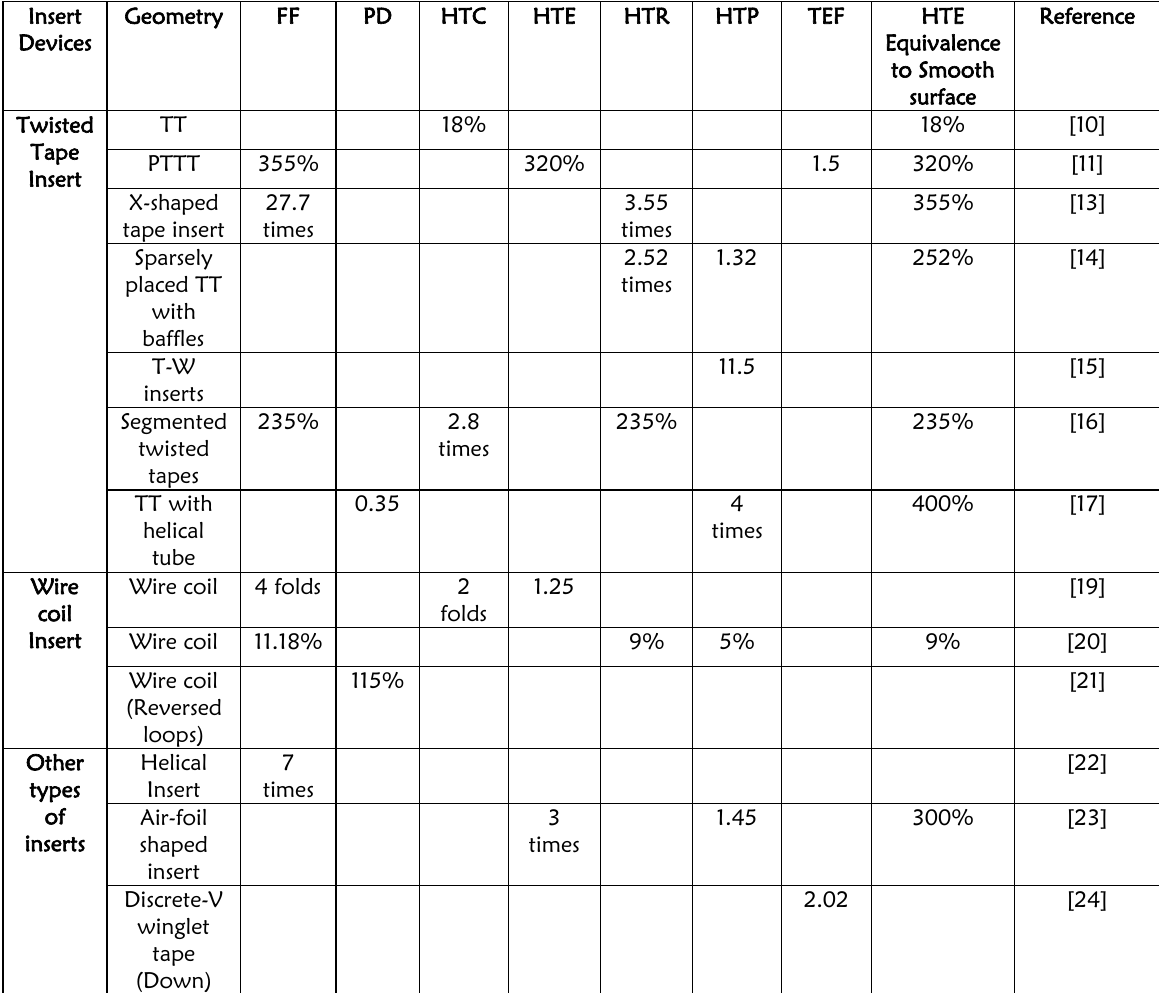
Table 3: Important findings of literature reviews regarding the heat transfer enhancement with various insert devices compared to smooth